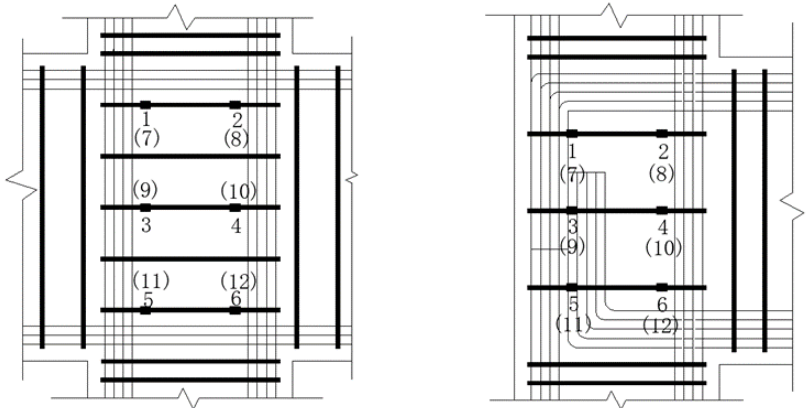
Figure 10. Arrangement of strain